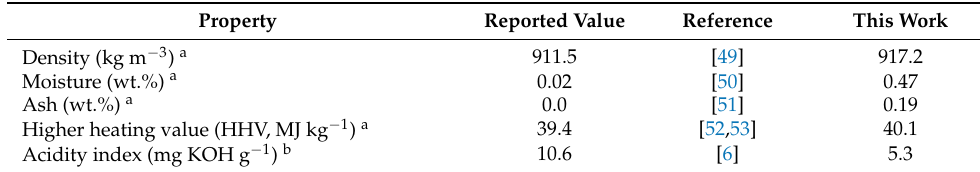
Table 2. Physicochemical properties of the waste cottonseed oil. Property Reported